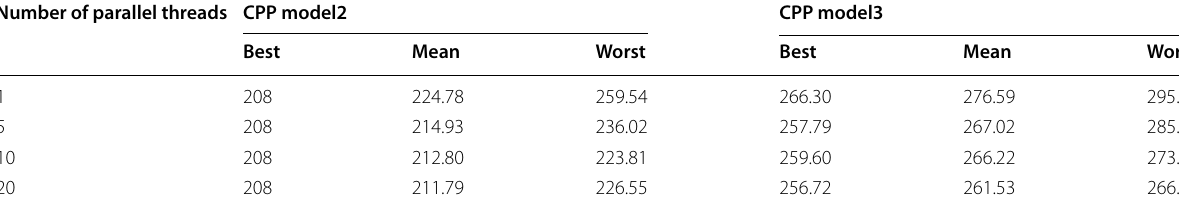
Table 7 Experiments for Performance Improvement using Parallel Computing Number of parallel threads CPP